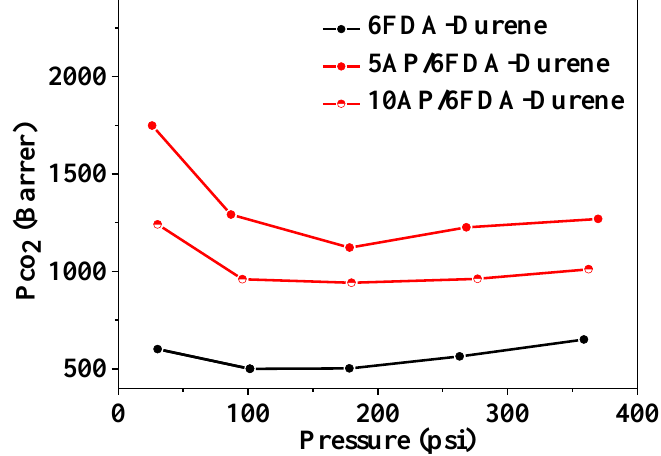
Figure 9. Plasticizing resistance of MMMs with AP loading.